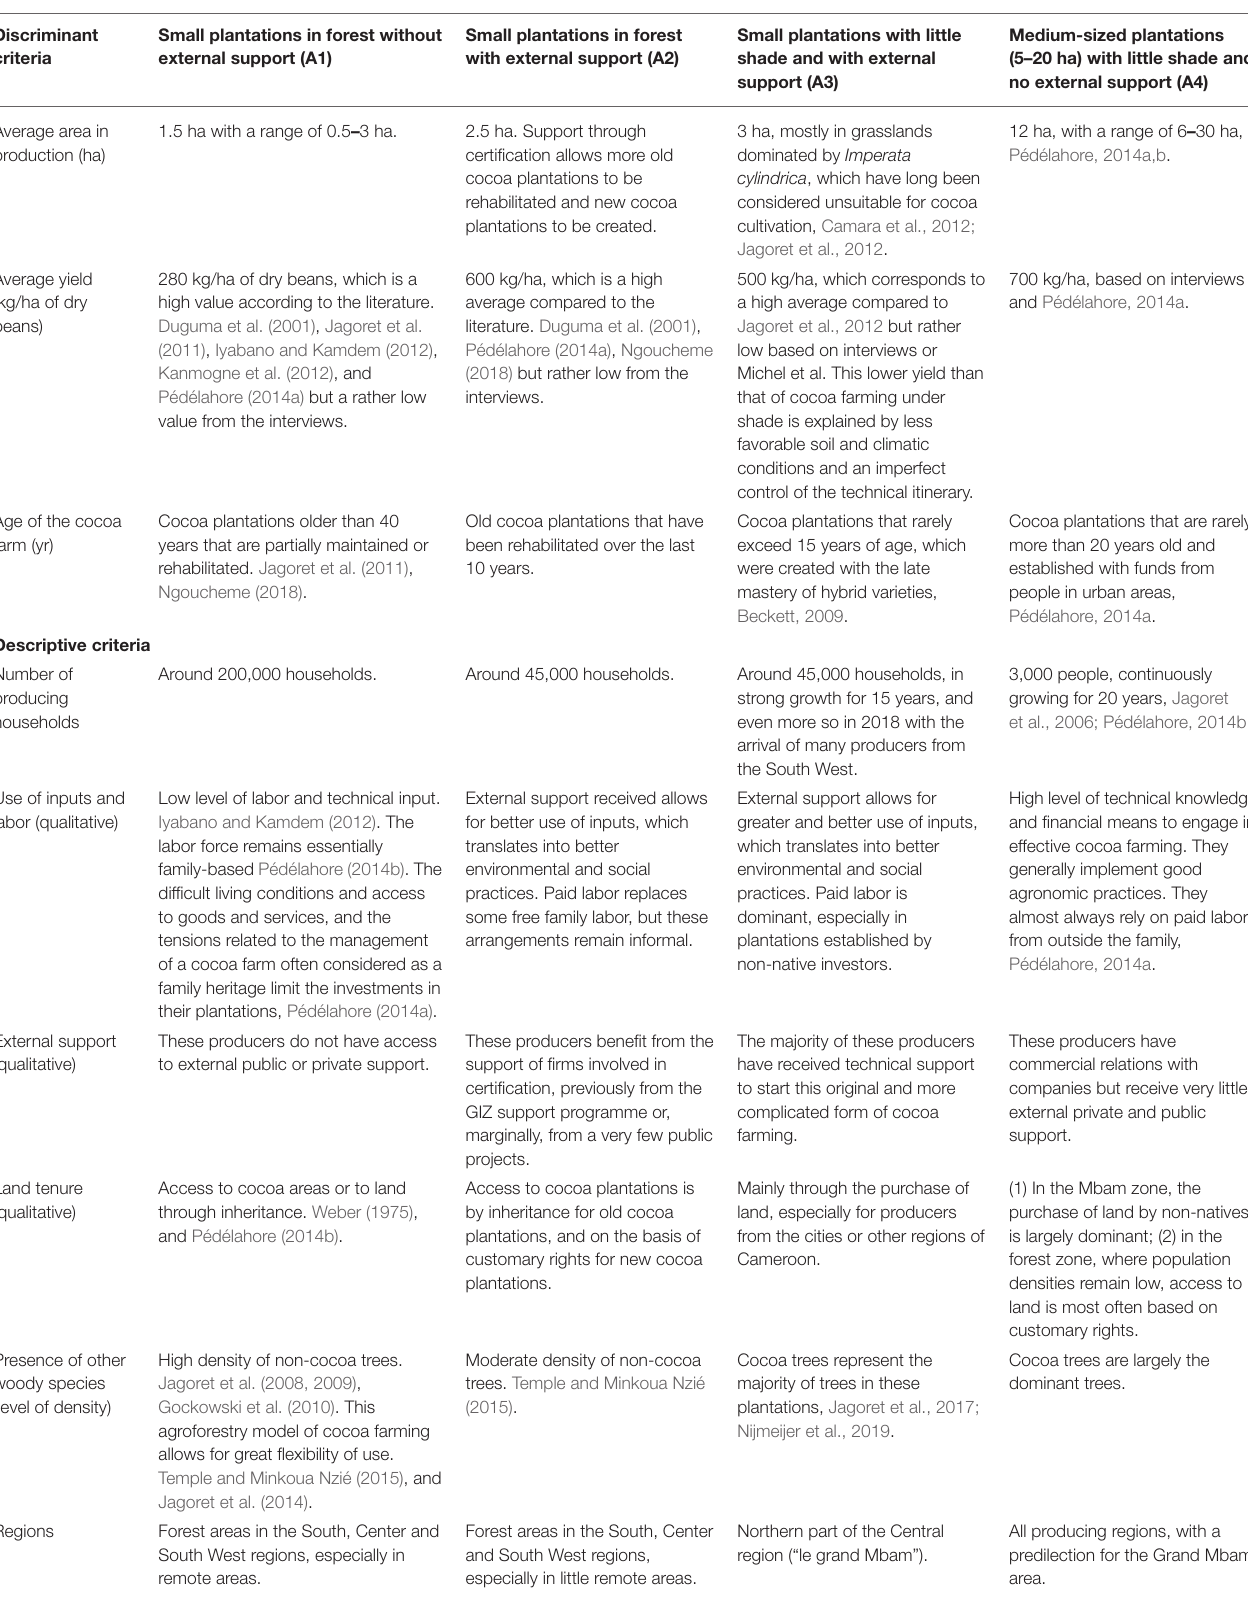
TABLE 1 | Main features of the archetypes of cocoa producers in